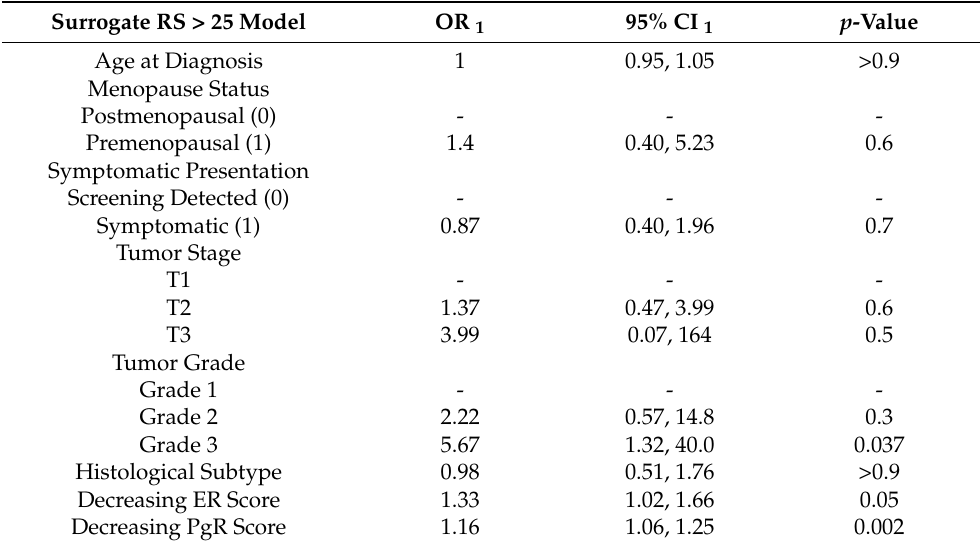
Table 3. Multivariable logistic regression analysis to predict clinicopathological data capable of predicting recurrence score >